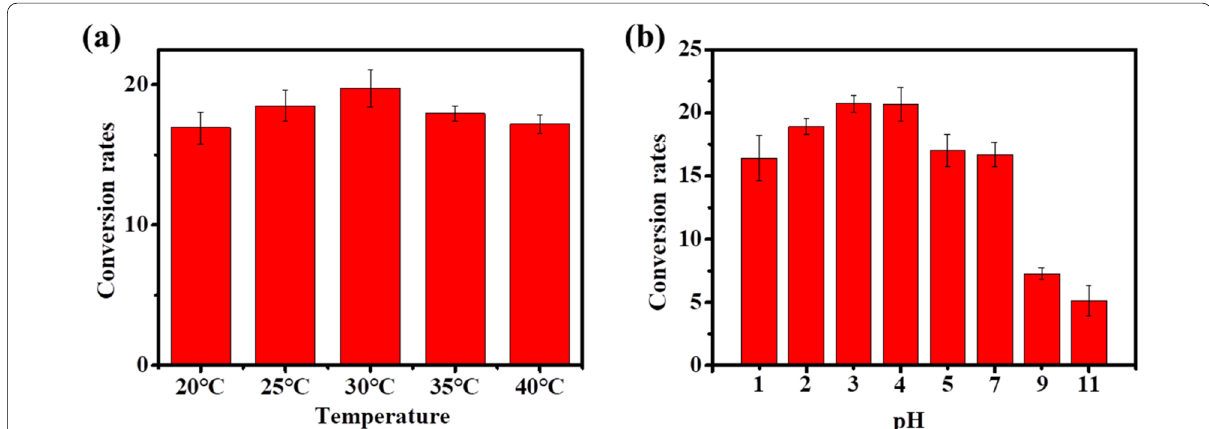
Fig. 3 a Effect of temperature on the SMA conversion of cytochrome C catalyzed ATRP under aerobic condition. b Effect of pH on the SMA conversion of cytochrome C catalyzed ATRP under aerobic